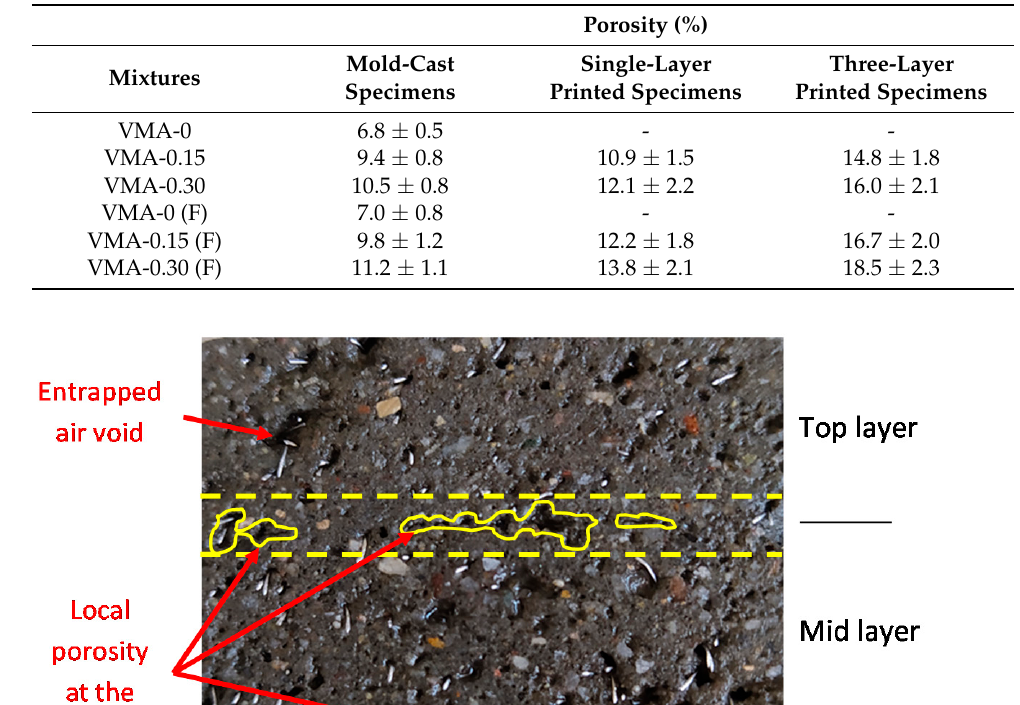
Table 5. Porosity values.